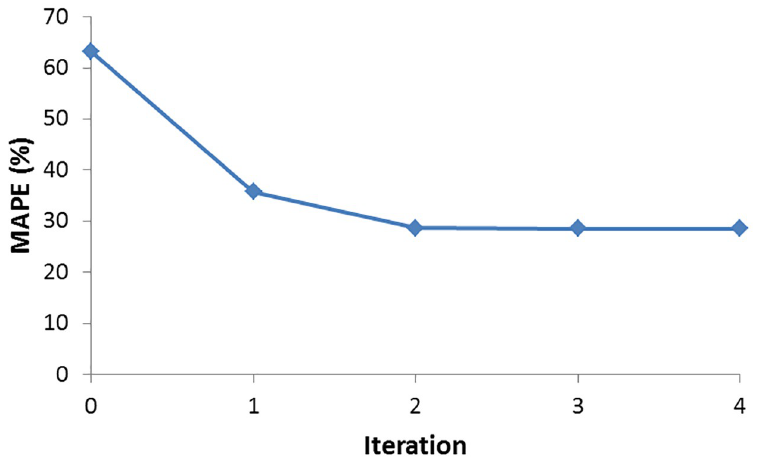
Fig 2. MAPE for maximum error trip over iterations.